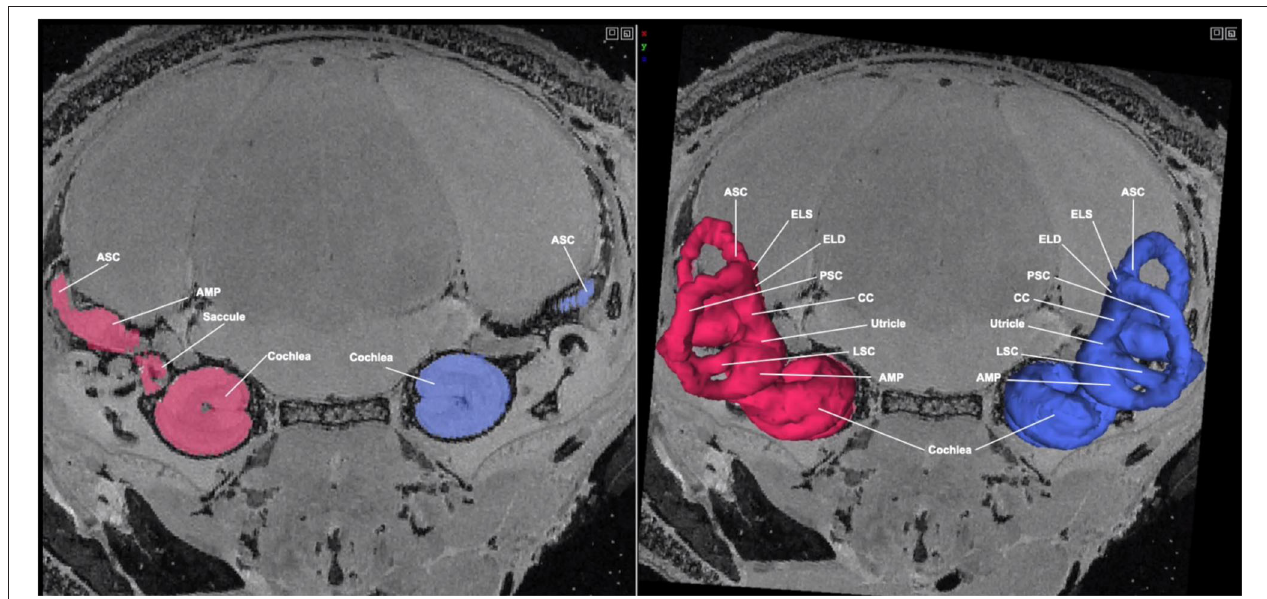
FIGURE 3 | MR image with 3D segmentation of the post-natal inner ear at P8. Shown here is an MR image of the post-natal day 8 mouse head in the coronal view. The 3D segmentation is seen overlayed on the 2D image (right). The color seen in the 2D image corresponds with its respective 3D segmentation. While the inner ear structures have not fully completed maturation, they have reached their mature configuration. ASC, anterior semi-circular canal; LSC, lateral semi-circular canal; PSC, posterior semi-circular canal; CC, common crus; ELS, endolymphatic sac; AMP, ampulla.